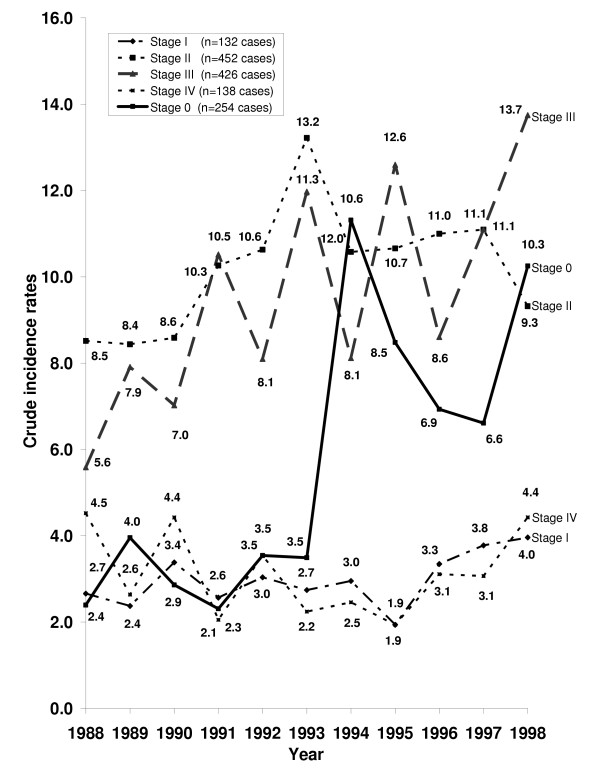
Crude incidence rates of the high-grade adenomas (n = 254) and the invasive adenocarcinomas of the colon (n = 1379) stratified by stage (TNM/UICC-AJCC, 1997) [14].